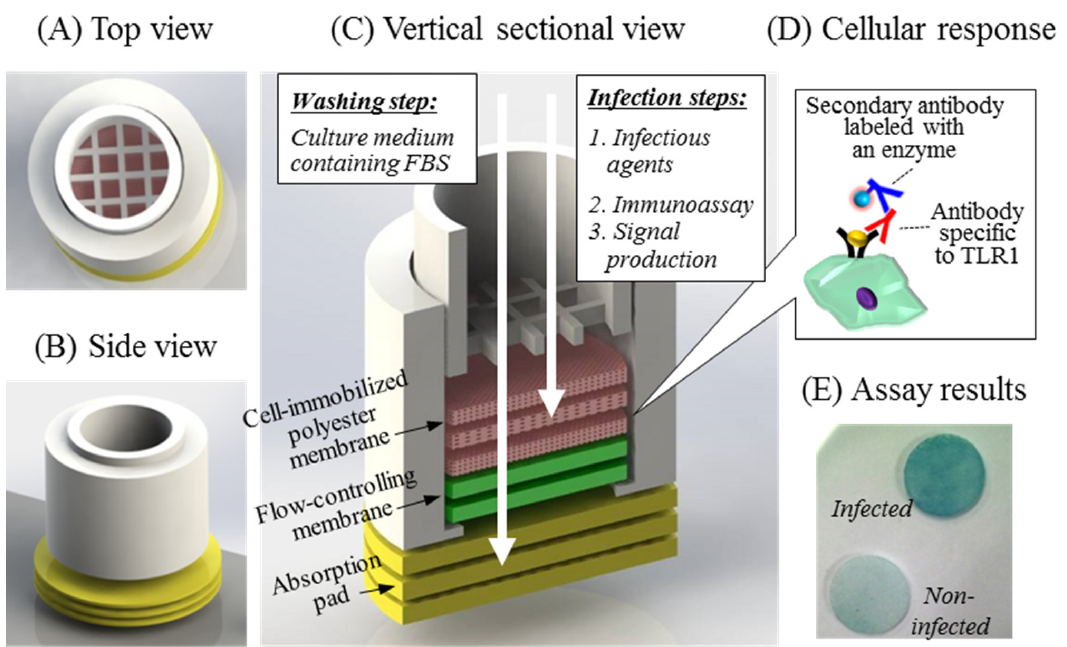
Figure 1. Schematics of the cell-based biosensing platform. ( A , B ) The design of the cell-based biosensing cartridge was fabricated by 3D printing. ( C ) The platform consisted of a sensing cartridge, cell culture scaffolds, flow-controlling membranes, and absorption pads. The flow-through format was used for culture medium change, washing, and pathogen infection in the assay. ( D ) The cellular response to the bacterial stimulation was obtained by detecting TLR1 expressed on the cell-attached membrane in the immunoassay. ( E ) The TLR1 densities were obtained by colorimetric signals on the 3D culture matrices.